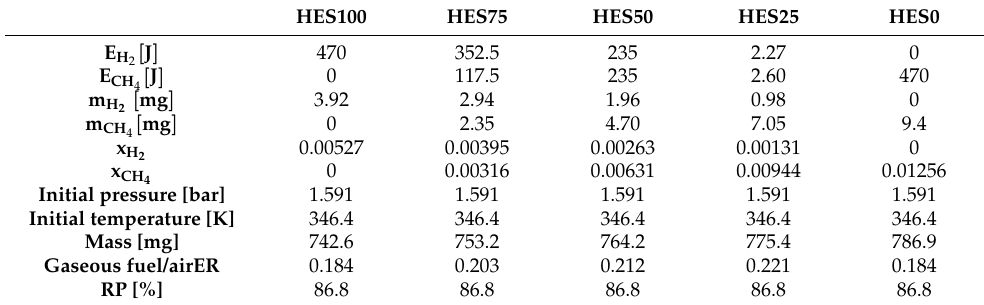
Table 9. Input data for the test